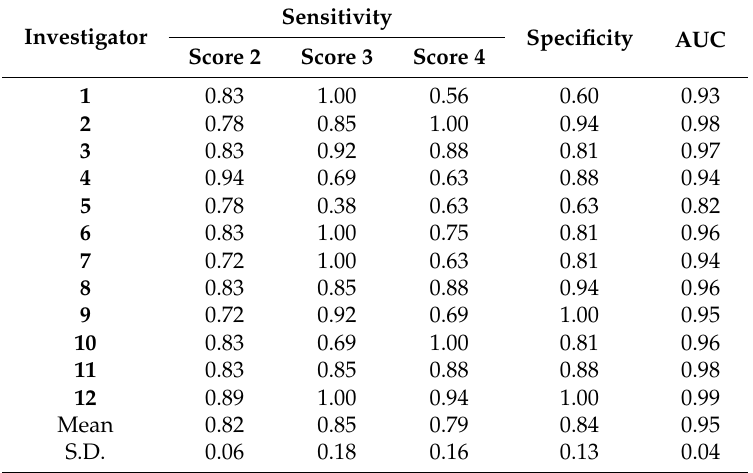
Table 1. Sensitivity (score 2, score 3, and score 4), specificity, and AUC values, obtained from SS-OCT.